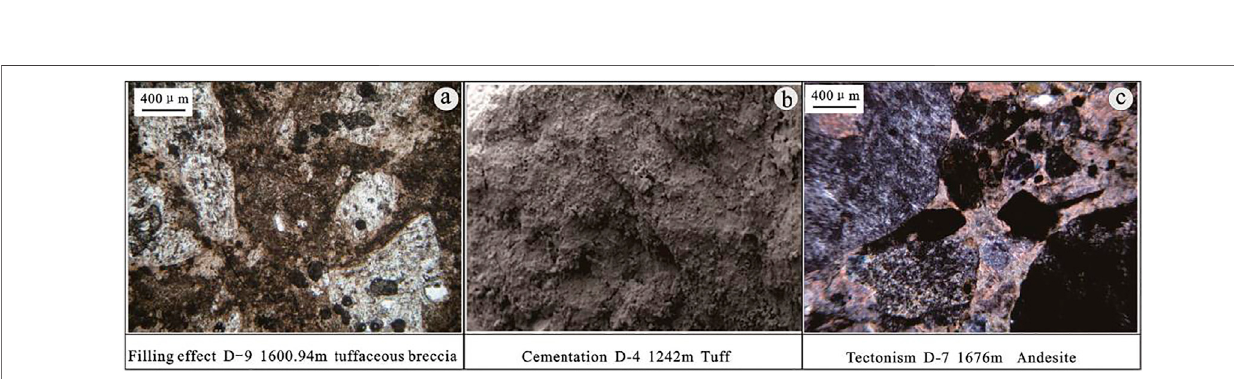
Frontiers in Earth Science |